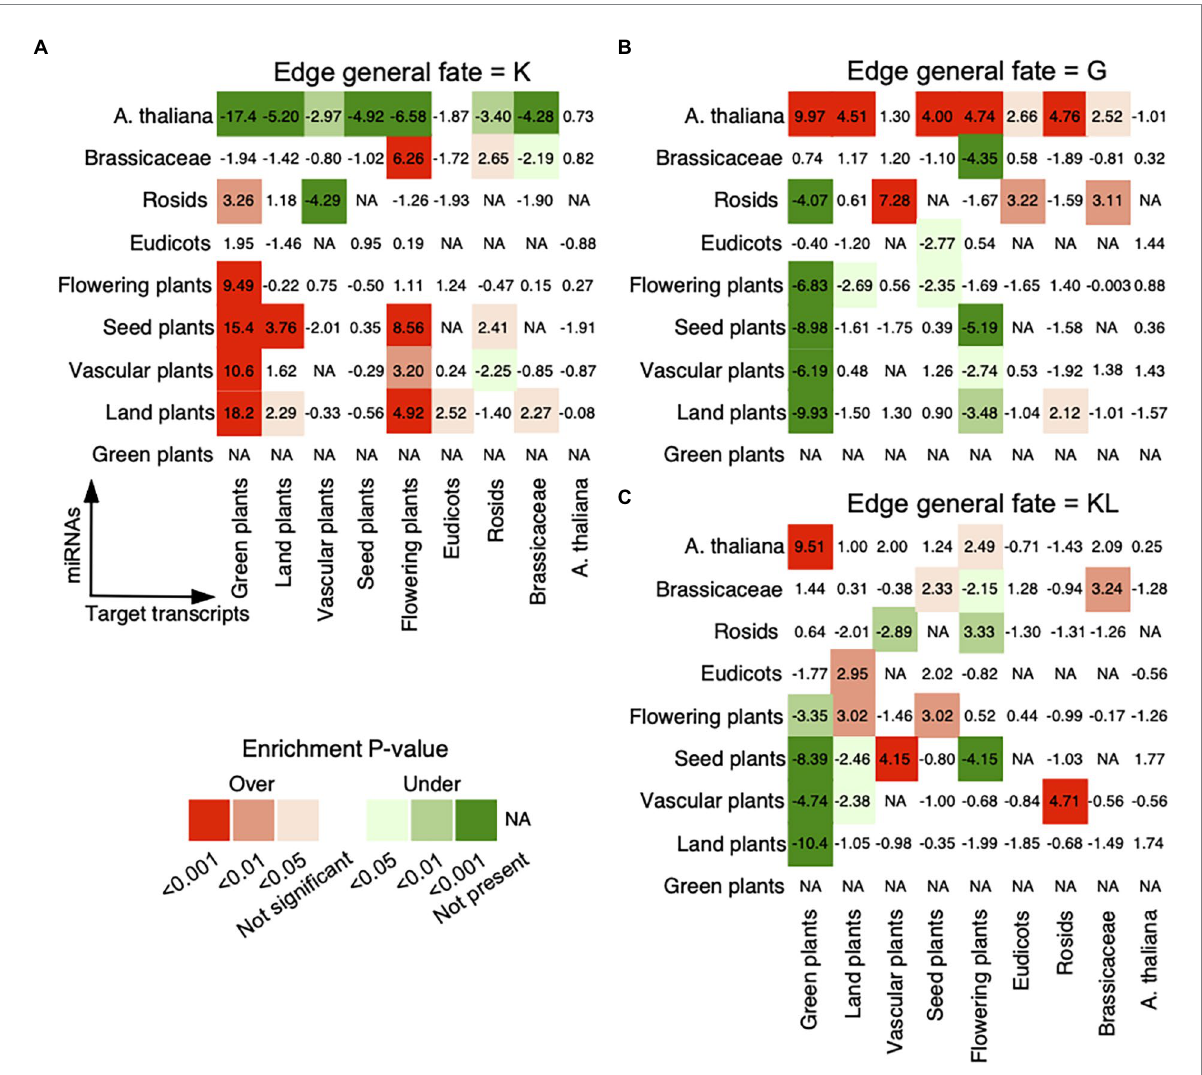
FIGURE 2 Age preference for miRNA–target regulations. The analysis was conducted for miRNA–target regulations with the general fates as (A) K, (B) G, and (C) KL. The observed number of regulatory pairs with the same fate within and between age groups in the real network was compared with the expected numbers in 1,000 randomized networks, which were generated by randomly assigning each general fate to an edge in the original network. The enrichment was calculated using Z-score (labeled within and between age groups) and the corrected p -value for multiple hypothesis testing (see Materials and methods). Overrepresentative results are shown in red and underrepresentative results are in green. The miRNAs are on the vertical axis and the target transcripts are on the horizontal axis. The oldest age of conserved miRNAs is Land